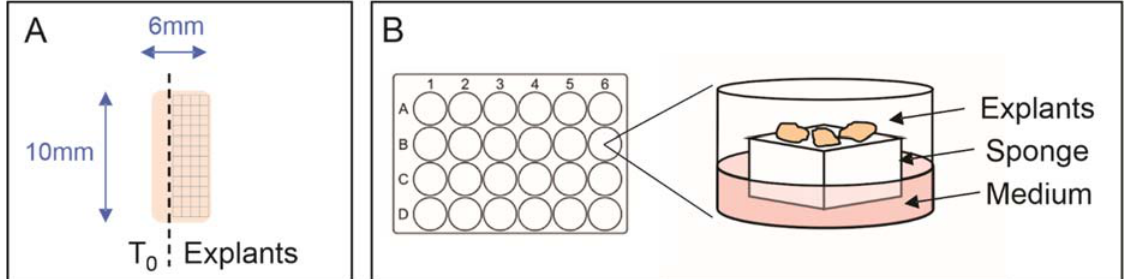
Figure 1. Schematic patient ‐ derived explant culture diagram. ( A ) Fresh prostate tumor specimens obtained from surgery are dissected longitudinally to obtain an uncultured sample at time zero (T 0 ). The remaining sample is dissected into 1 mm 3 pieces for explant culture. ( B ) Explants are cultured on gelatin sponges sitting in medium in 24 ‐ well plates, where each well is dedicated to a specific treatment and/or endpoint and contains a minimum of triplicate explants.